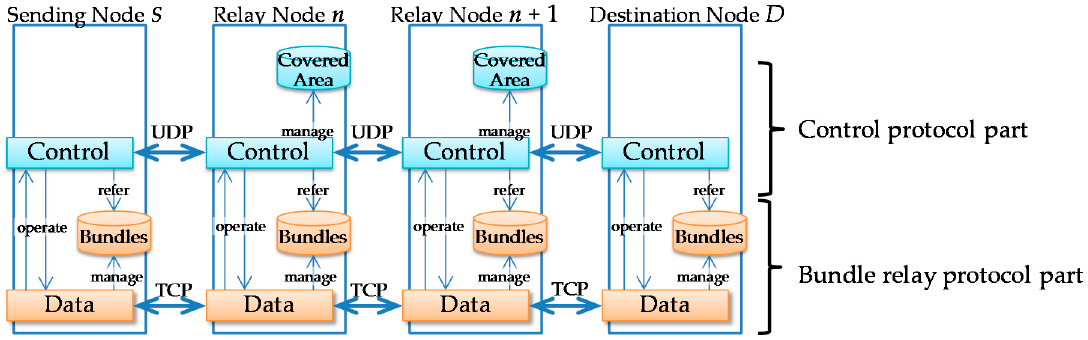
Figure 9. The control protocol part and the bundle relay protocol part for traveling route information ‐ based